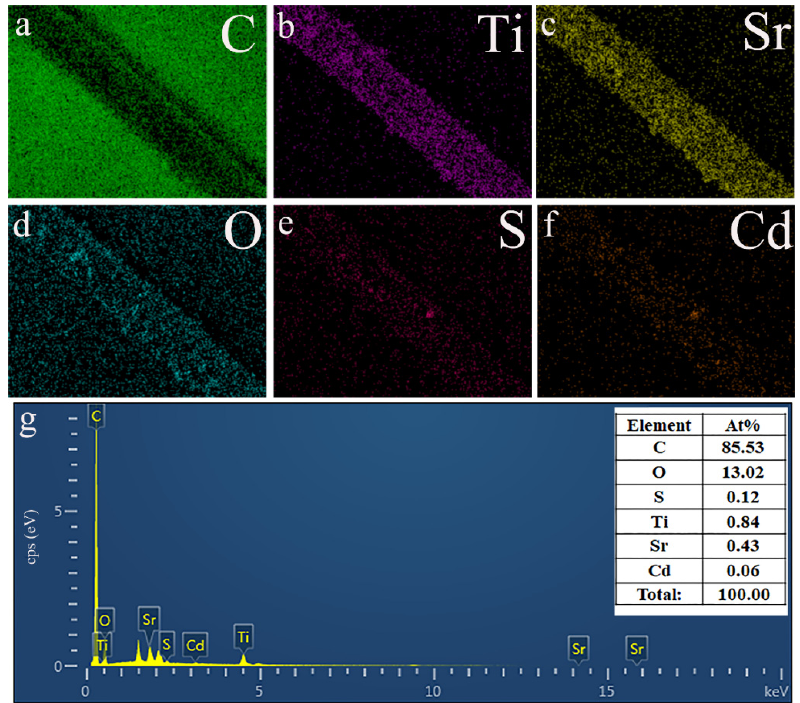
Figure 3. Element distribution of CF/SrTiO 3 /CdS photocatalytic fiber: ( a ) C element, ( b ) Ti element, ( c ) Sr element, ( d ) O element, ( e ) S element, ( f ) Cd element, and ( g ) element content diagram of CF/SrTiO 3 /CdS.